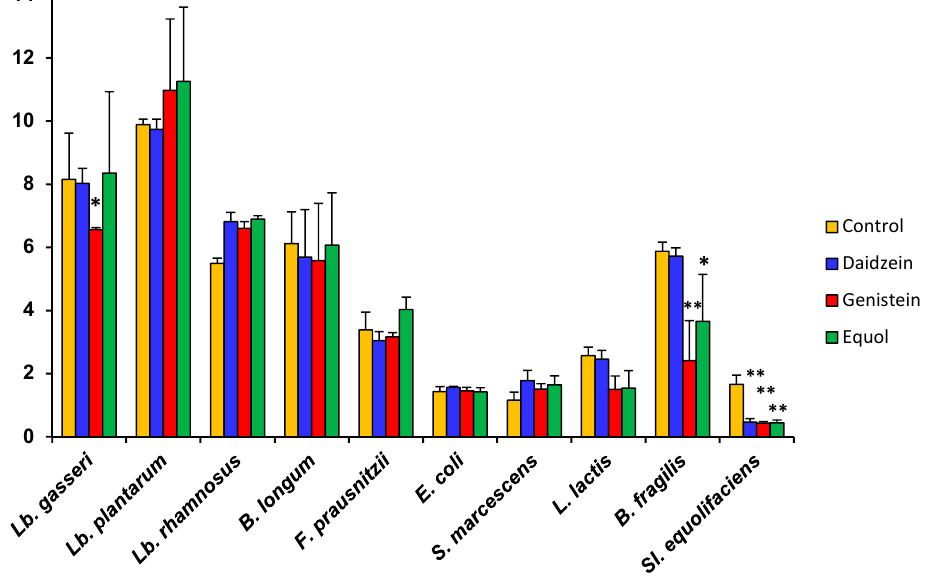
Figure 2. Final optical density (OD) at 600 nm after 24 h incubation of ten bacterial strains in the presence of 32 μ g mL − 1 of either daidzein, genistein, or equol, as compared to a control without phenolics. Standard deviation (SD) is indicated by vertical bars. Mean values were compared by the Student’s t -test. Statistical significance: * p ≤ 0.05, ** p ≤ 0.01.